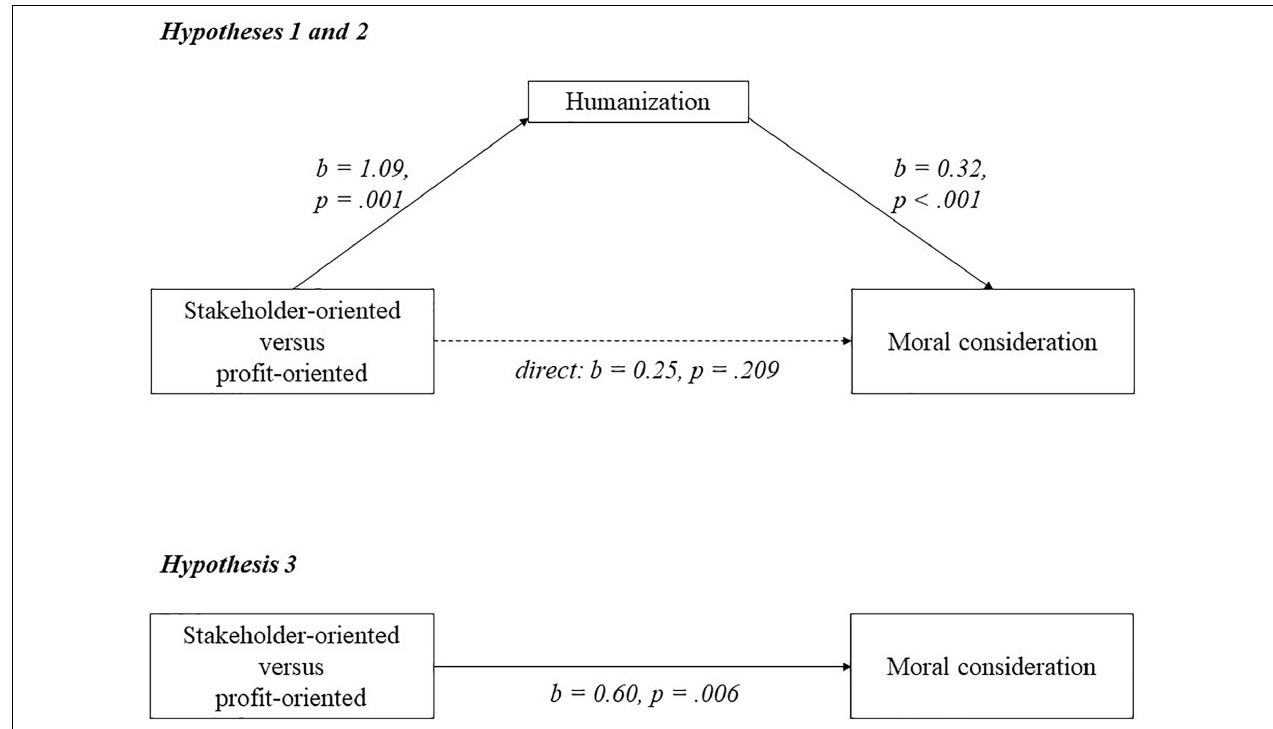
FIGURE 5 | A model of mediation indicating that the relationship between business orientation and moral consideration goes via humanization in experiment 6.